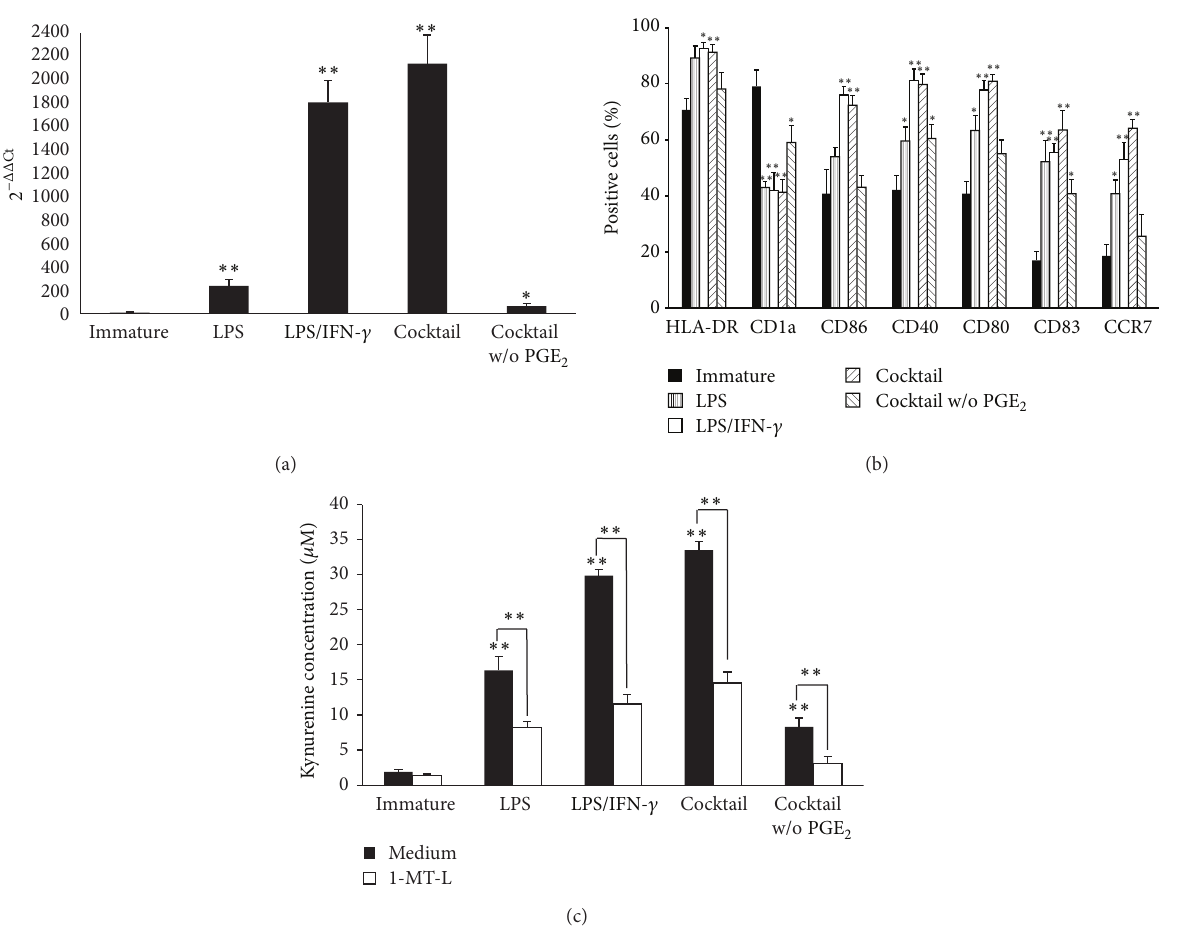
Figure 1: Mature DCs expressed a functionally active IDO1 protein. Human CD14 + cells were isolated from healthy donors’ PBMC by using magnetic beads. Immature Mo-DCs were obtained after a 5-day culture in presence of GM-CFS and IL-4. Mature Mo-DCs were obtained following2daysofincubationwithLPS,LPSplusIFN- 𝛾 ,thecytokinecocktailmadeofIL-1 𝛽 ,IL-6,andTNF- 𝛼 ,withorwithoutPGE 2 .(a)Cells werelysedandRNAwasextracted.mRNAexpressionofIDO1(normalizedtoGAPDH)wasevaluatedbyreal-timeRT-PCR.Universalhuman RNA was used as reference and taken as value of 1. Data are expressed as the mean ± SEM of 7 independent experiments. ∗ 𝑃 < 0.05 , ∗∗ 𝑃 < 0.01 versus immature DCs. (b) DC phenotype was evaluated by flow cytometry. (c) DCs were cultured in presence of 500 𝜇 M L-tryptophan for 4h and supernatants were collected. IDO1 enzymatic activity was evaluated with a spectrophotometric analysis as the production of kynurenine in the supernatants. Data are expressed as the mean ± SEM of 5 independent experiments. ∗ 𝑃 < 0.05 , ∗∗ 𝑃 < 0.01 versus immature DCs or versus medium